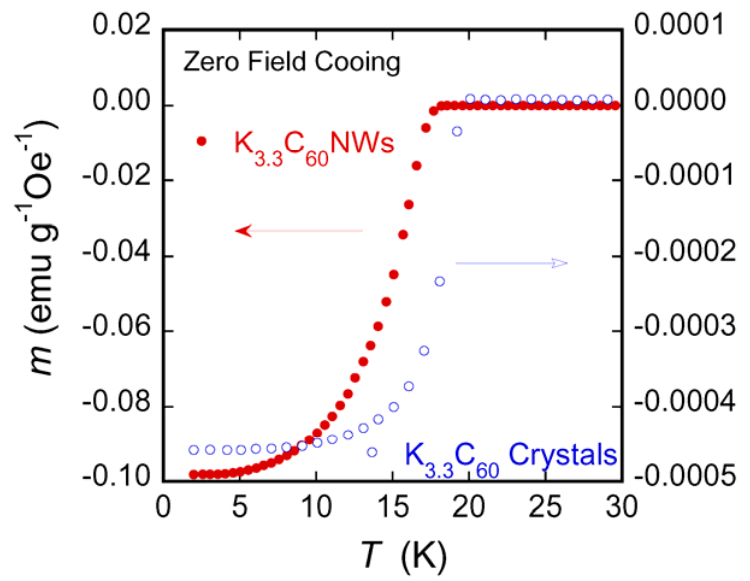
Figure 2. The temperature dependencies of the normalized magnetic moments m for C NWs and K C K 3.3 60 3.3 60